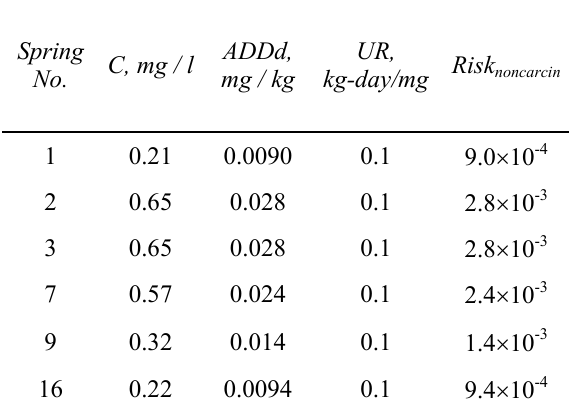
Table 4: Calculated health risk for drinking water containing aluminum